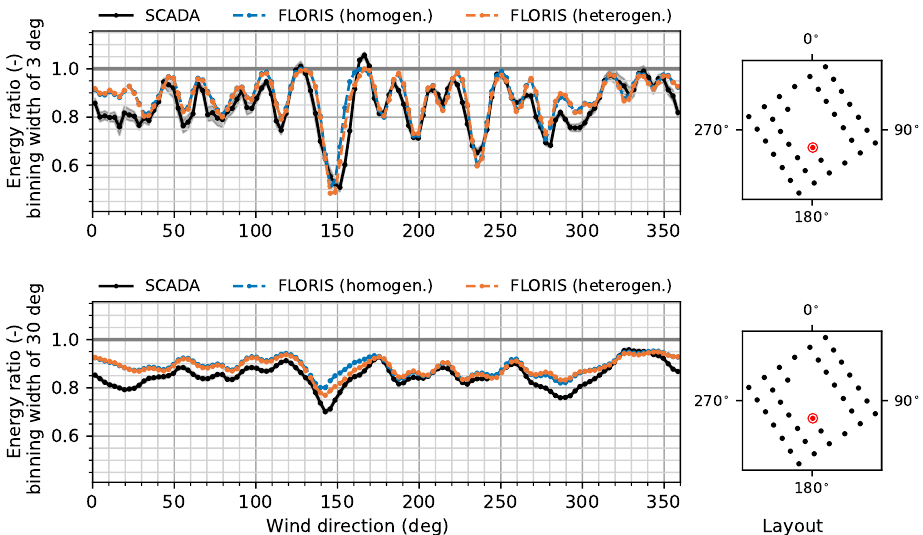
Figure 13. Energy ratio curves for Turbine 16 in the Westermost Rough wind farm, where the reference turbines are all upstream turbines within a 5 km radius, and the reference wind direction is the average of the nacelle headings of Turbines 9, 8, 15, and 25. The shaded regions represent 90% confidence intervals obtained through bootstrapping. The layout schematic on the right shows the location of Turbine 16 in the wind farm.